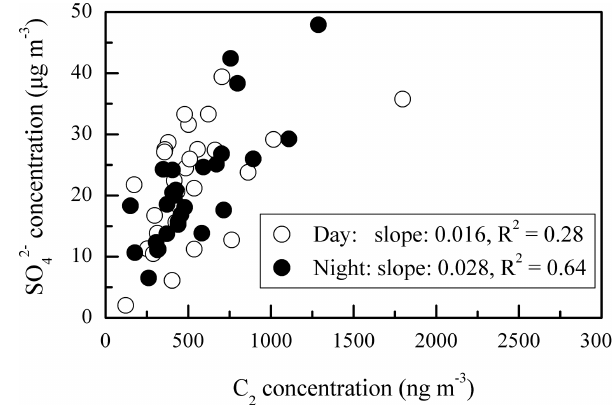
Figure 7. Day and night scatter plot between C 2 and SO 2 −